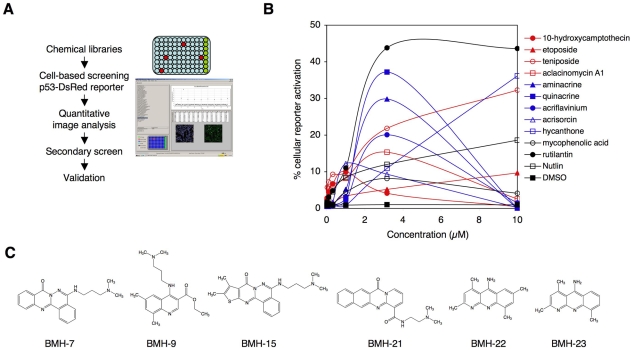
Cell-based high-content imaging screen.A) Screen outline. B) Spectrum Collection experimental drug library was analyzed using the p53 reporter screen. Primary hits were validated at 10-fold concentration range. Color code; red, TOP1/2 inhibitors; blue, DNA intercalating agents; black, other. C) Chemical structures of hit compounds in the large-scale small-molecule compound screen.